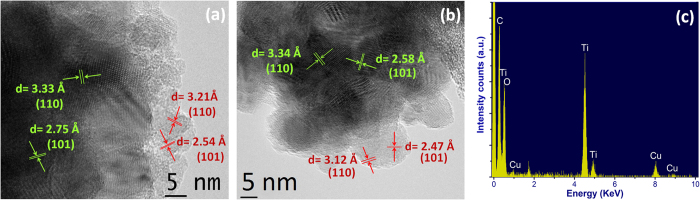
HRTEM images of (a) TiCl4 treated and (b) TiOx treated SnO2 nanoparticles. (c) EDX spectra confirming the presence of constituent elements of TiO2 when selectively done on the TiO2 nanoparticles covering the SnO2 nanoparticles, the presence of Cu and C is due to the grid used as sample holder.